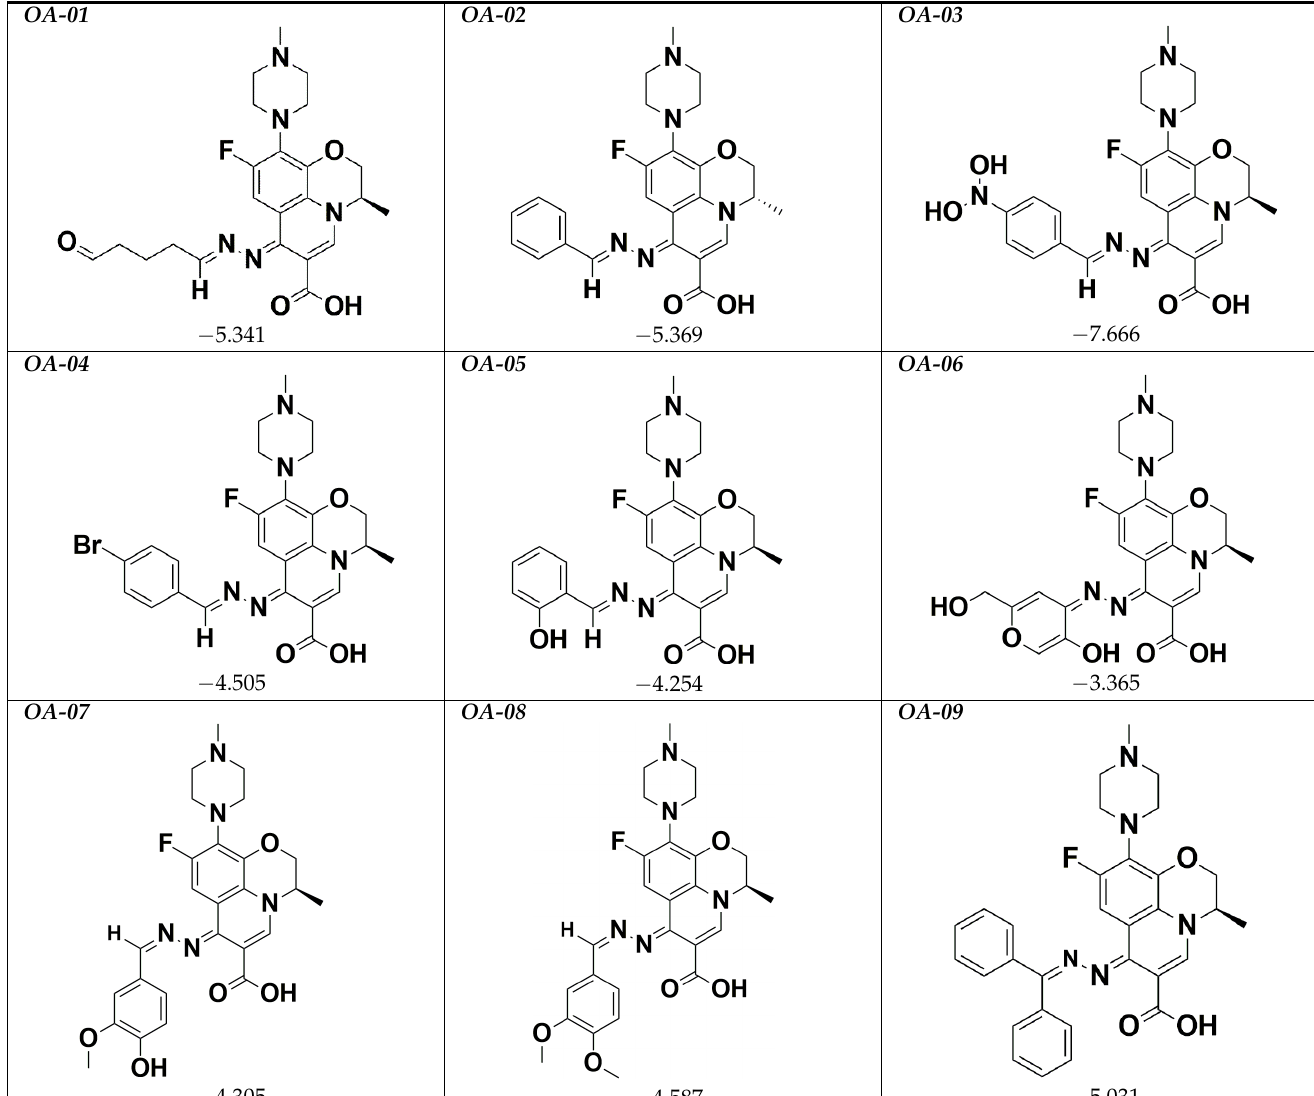
Table 2. The glide scores of the OA series compounds with corresponding structures.